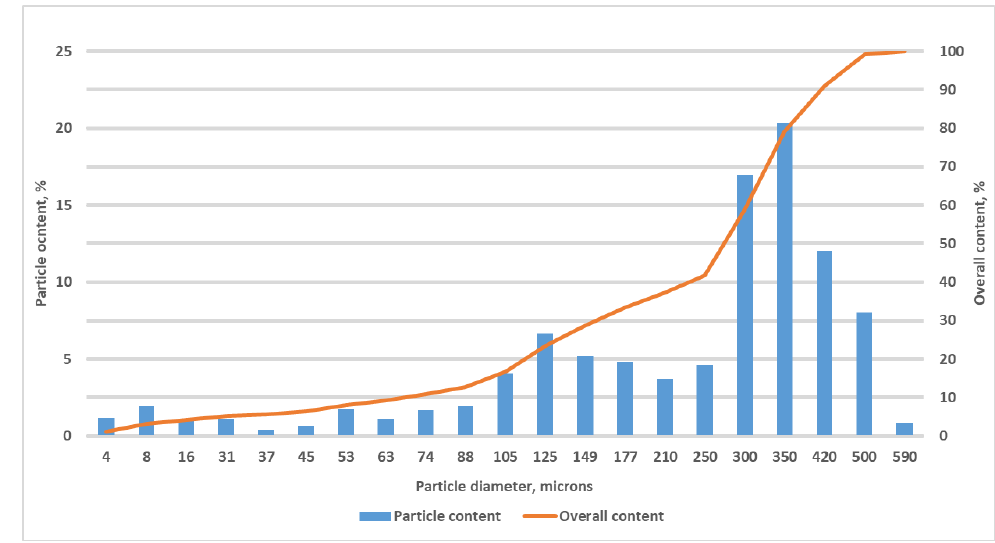
Figure 4. Formation particle size distribution.